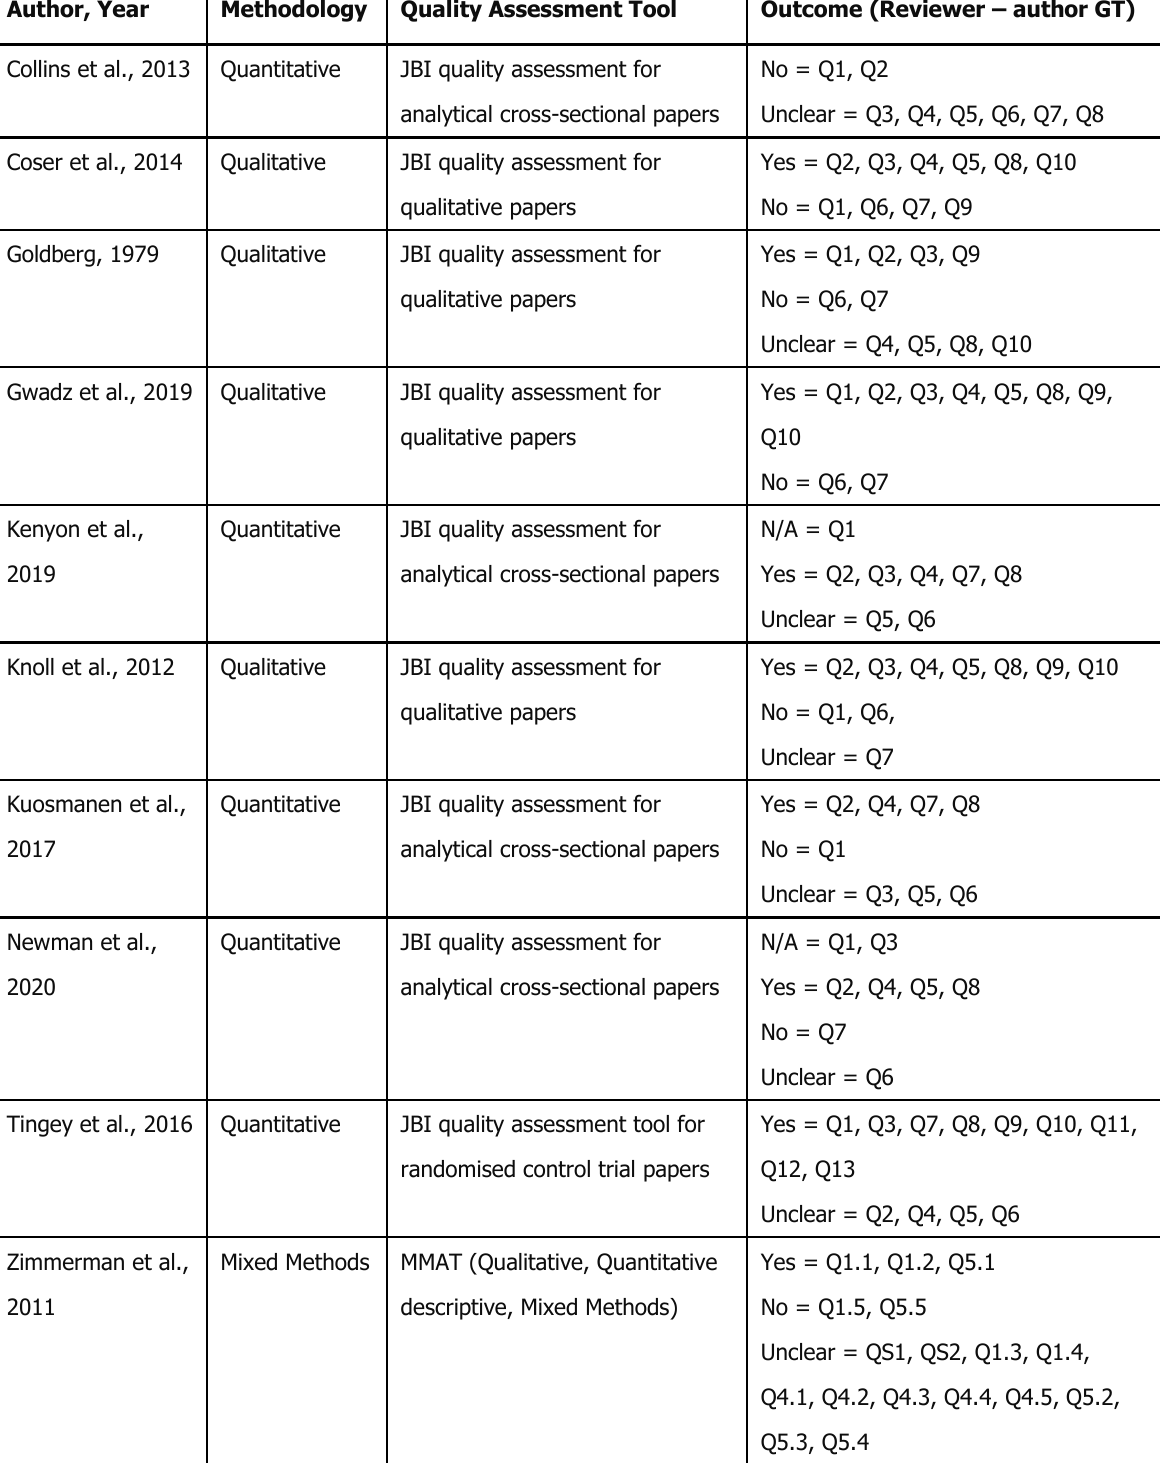
Table B1. Quality Assessment Results for Each